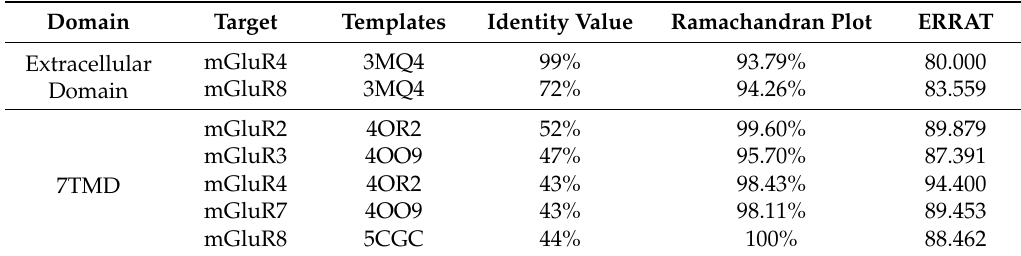
Table 4. Selection of template proteins and evaluation of models.